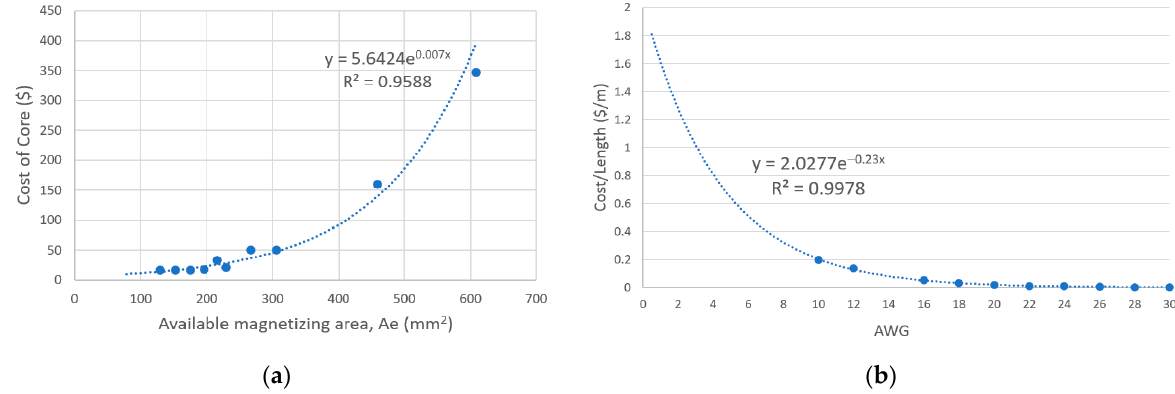
Figure 20. Cost model of inductor: ( a ) Core price per available magnetizing area, A e ; ( b ) wire price according to AWG.